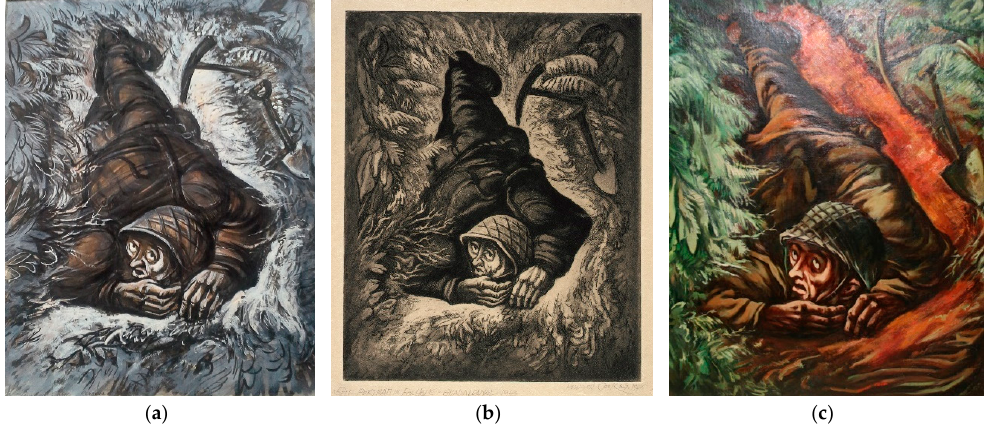
Figure 1. The three renditions of Self-Portrait in a Foxhole : ( a ) Howard Cook, Self-Portrait in a Foxhole